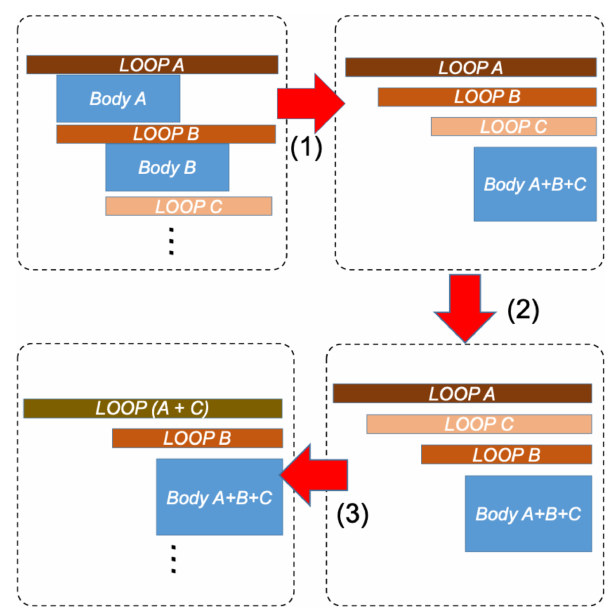
Figure 7. Typical loop transformations performed to achieve the most suitable loop bodies that fit the number of parallel cores and the size of fast buffer in each core of the SW26010 many-core pro- cessor. (1) Aggregation of the loop body into the most inner loop, (2) interchange of loops B and C, and (3) merging of loops A and